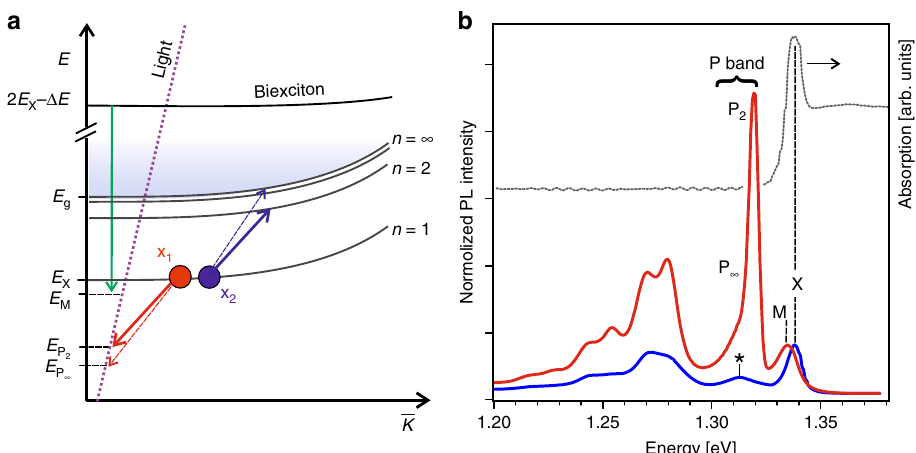
Fig. 1 Exciton, biexciton, and exciton – exciton scattering. a Schematic representation of the biexciton decay and the X – X scattering which involves the n = 2 and n = ∞ states shown by solid and dashed arrows, respectively. The exciton-level notation is given for the 3D case; it should start from n = 0 for the 2D case. The characteristic energies are marked on the vertical axis ( Δ E ≈ E X − E M ). b Photoluminescence spectra (linear scale) measured under low (50 Wcm − 2 , blue line) and high (0.3 MWcm − 2 , red line) excitation powers in undoped InSe. An absorption spectrum (gray line) is shown for